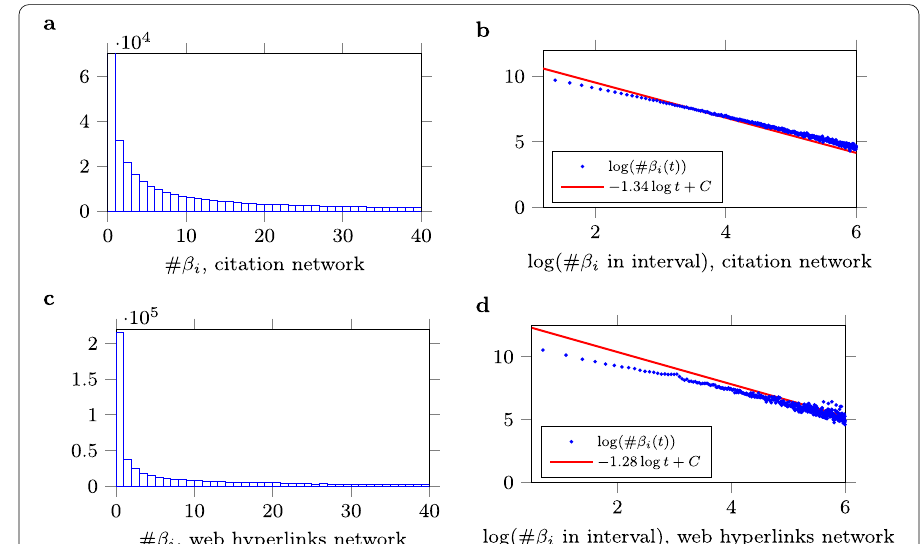
Figure 2e, f show the distribution of friendship index for network based on 2019 snapshot of a number of Github users. Individuals represented in nodes are con- nected if there are mutual follower relationships between